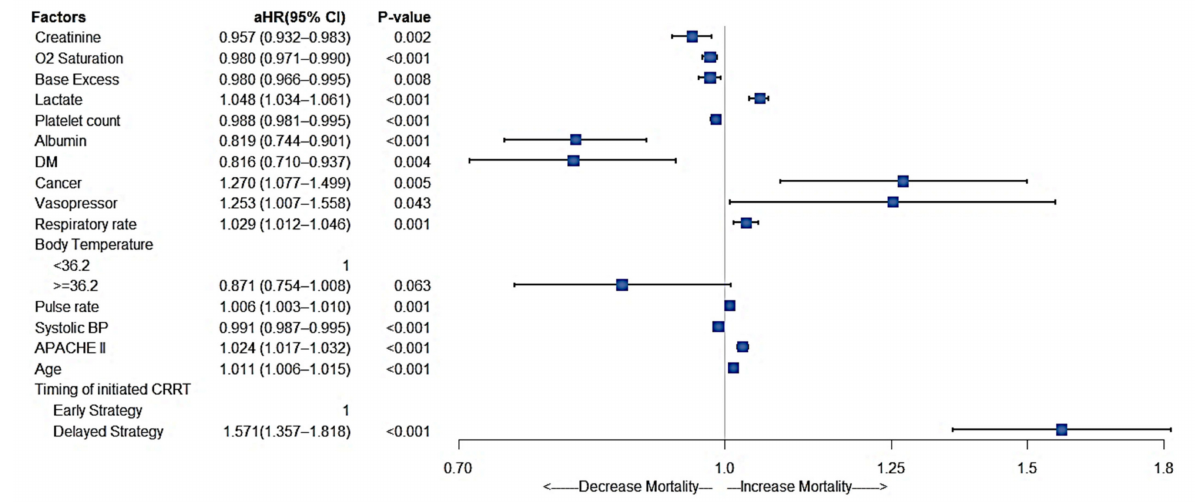
Figure 5. Other significant factors associated with